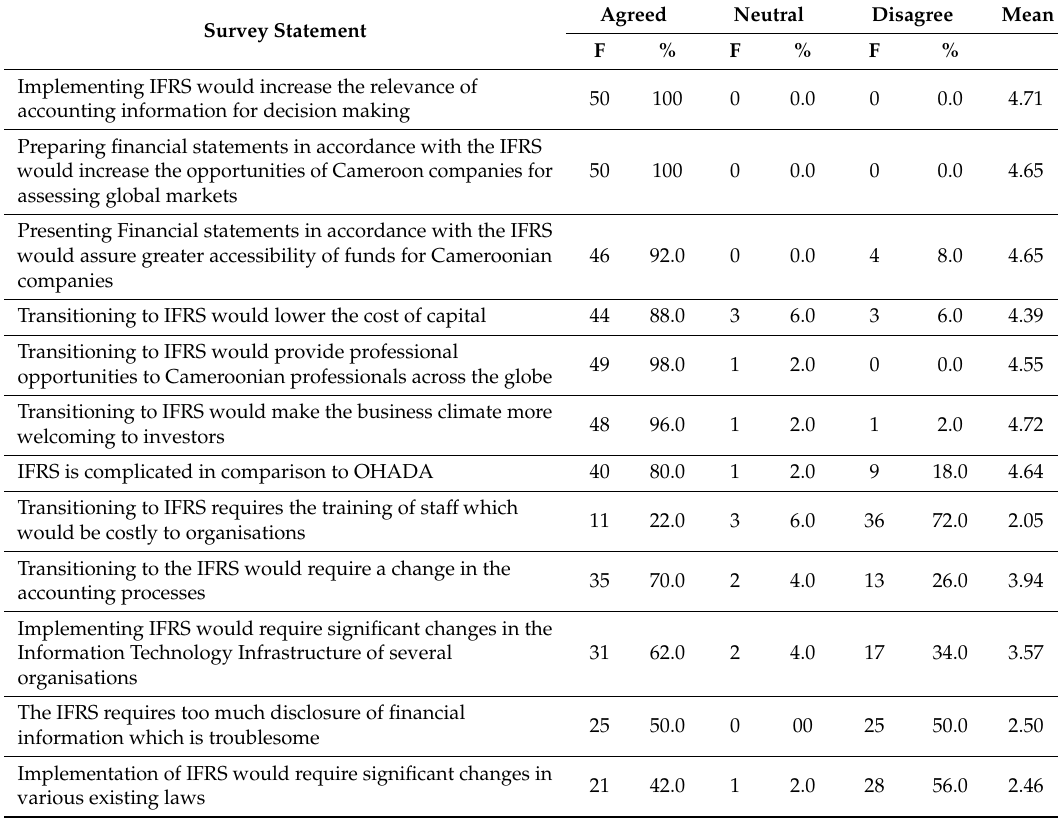
Table 6. Respondents’ perceptions of the costs and benefits involved in transitioning from the Organisation for the Harmonisation of Business Laws in Africa (OHADA) GAAP to IFRS. Agreed Neutral Disagree Mean Survey Statement F %